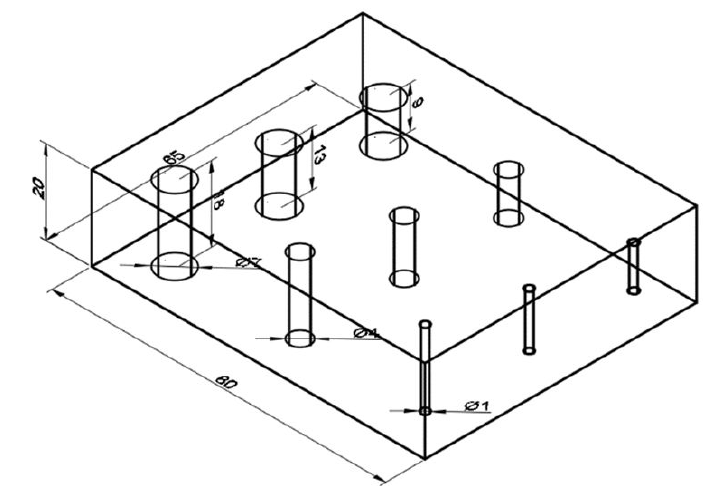
Figure 1. CAD model of the